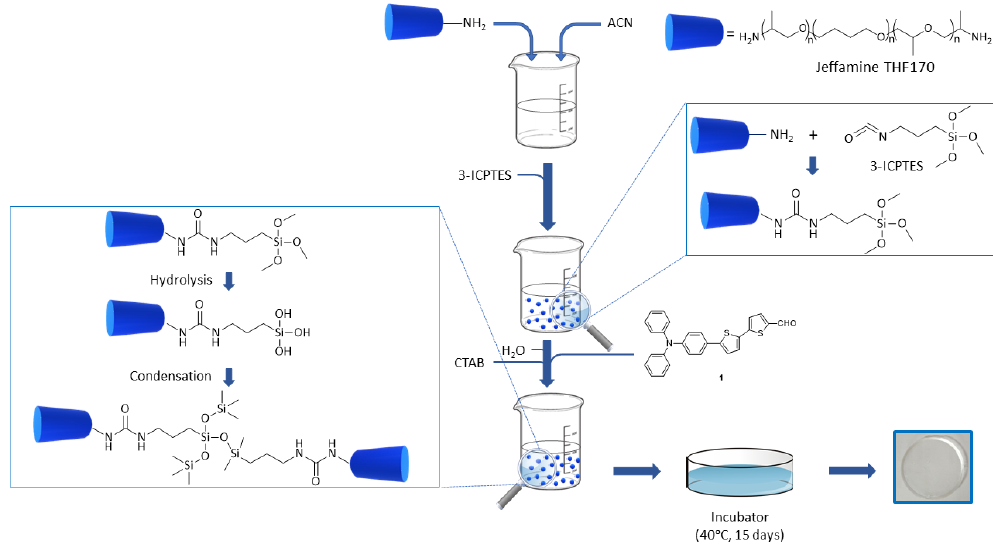
Figure 3. Synthesis steps of OIH materials (pure and doped with compound 1 ).